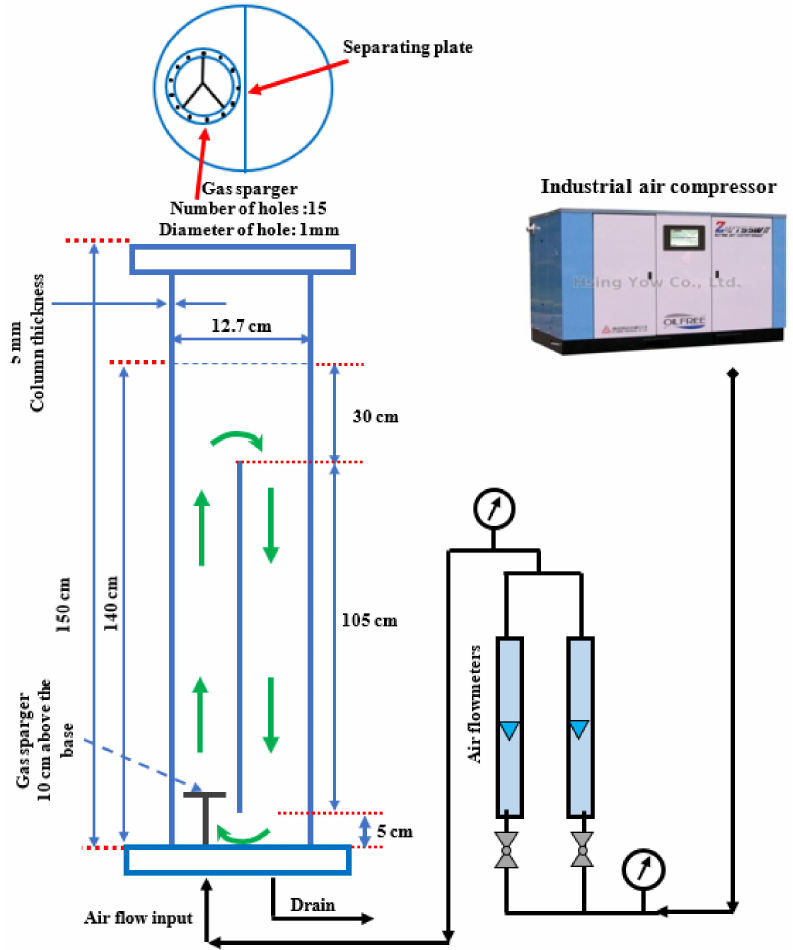
Figure 1. A cylindrical airlift split-plate